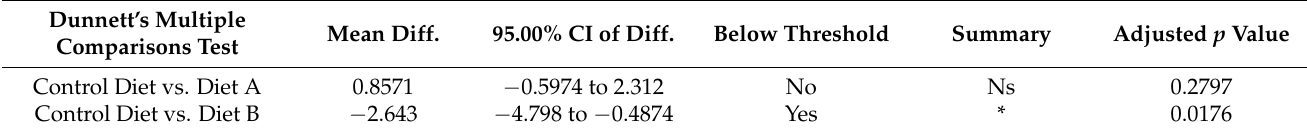
Table 3. Dunnett’s multiple comparisons test between post-larvae of P. lividus feeding on control diet ( U. rigida ), diet A ( U. rigida , SHG ® microperle, Algamac Enrich) and diet B ( U. rigida , 2% spirulina SHG ® ) of the trial. Threshold p < 0.05. (* = statistically significant; ns = not statistically significant). Dunnett’s Multiple Mean Diff. 95.00% CI of Diff. Comparisons Test